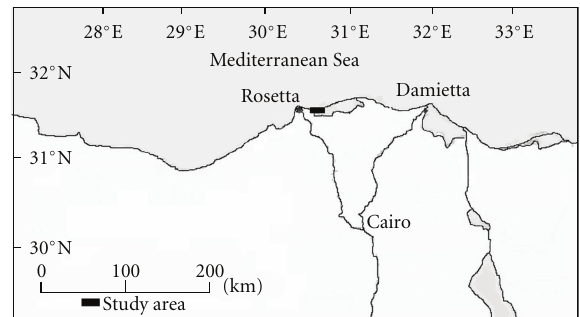
Figure 1: Map of Northern Egypt showing the location of the study area.